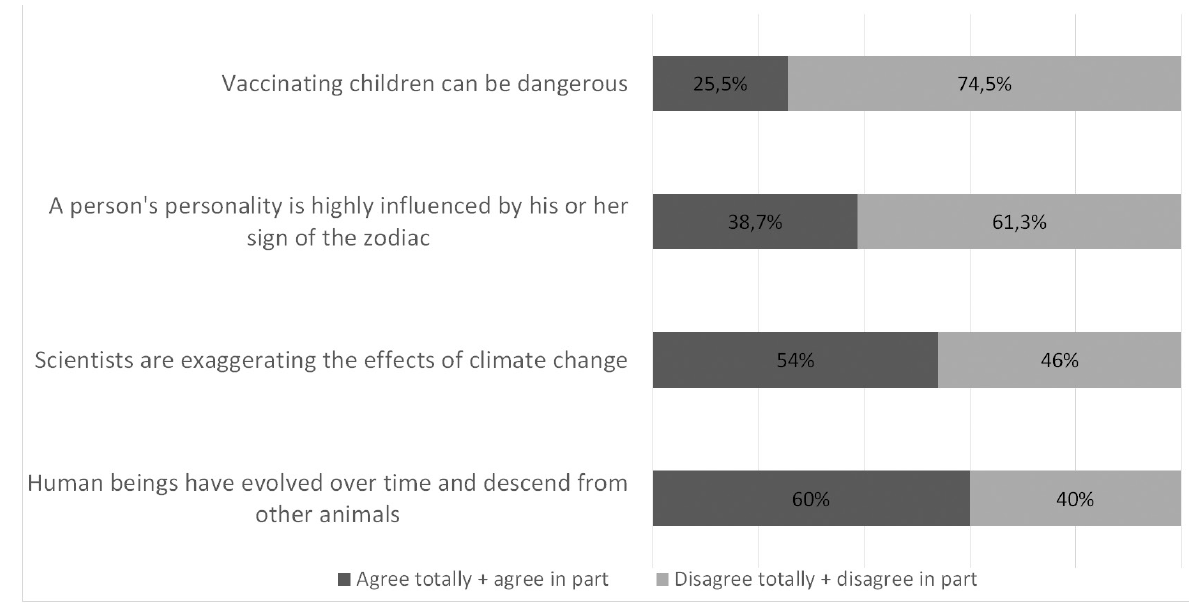
Figure 4. Opinions about controversial topics Survey question related to Figure 4: I’m going to read some statements about science and technology. Tell me to what extent you agree or disagree with each one. (agree totally, agree in part, disagree in part, disagree